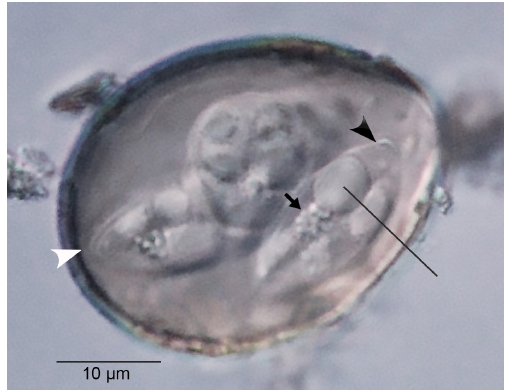
Figure 3. Nomarski interference contrast photomicro- graph of sporulated Eimeria rangiferis oocyst from feces of an Ameralik caribou calf (mixed native caribou and semi-domestic Norwegian reindeer) of West Greenland. Microphyle on the top of the oocyst is not in focus. Note the sporocyst residuum ( arrow ), 1 refractile body ( line ) in each sporozoite, and the Stieda body ( black arrowhead ). The spindle-shaped sporocyst has a slightly pointed end opposite the prominent Stieda body ( white arrowhead ). Bar = 10